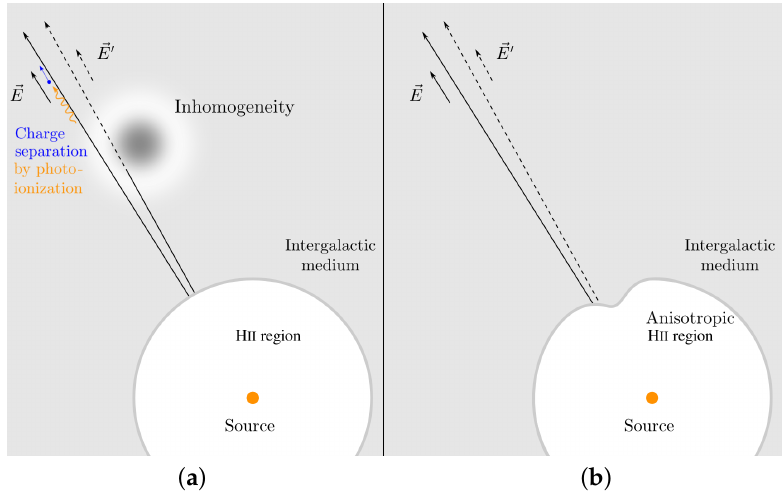
Figure 1. Inhomogeneities at the origin of rotational electric fields. An ionizing source creates an H II bubble around itself. Photons above the hydrogen ionization threshold may propagate deeper into the IGM, where, occasionally, they hit neutral atoms and eject new electrons. This process occurs continuously, and the resulting charge separation induces an electric field. This electric field may possess a curl either ( a ) because of gas inhomogeneities present in the IGM or ( b ) because of anisotropies in the bubble boundary that both induce differences in adjacent photon